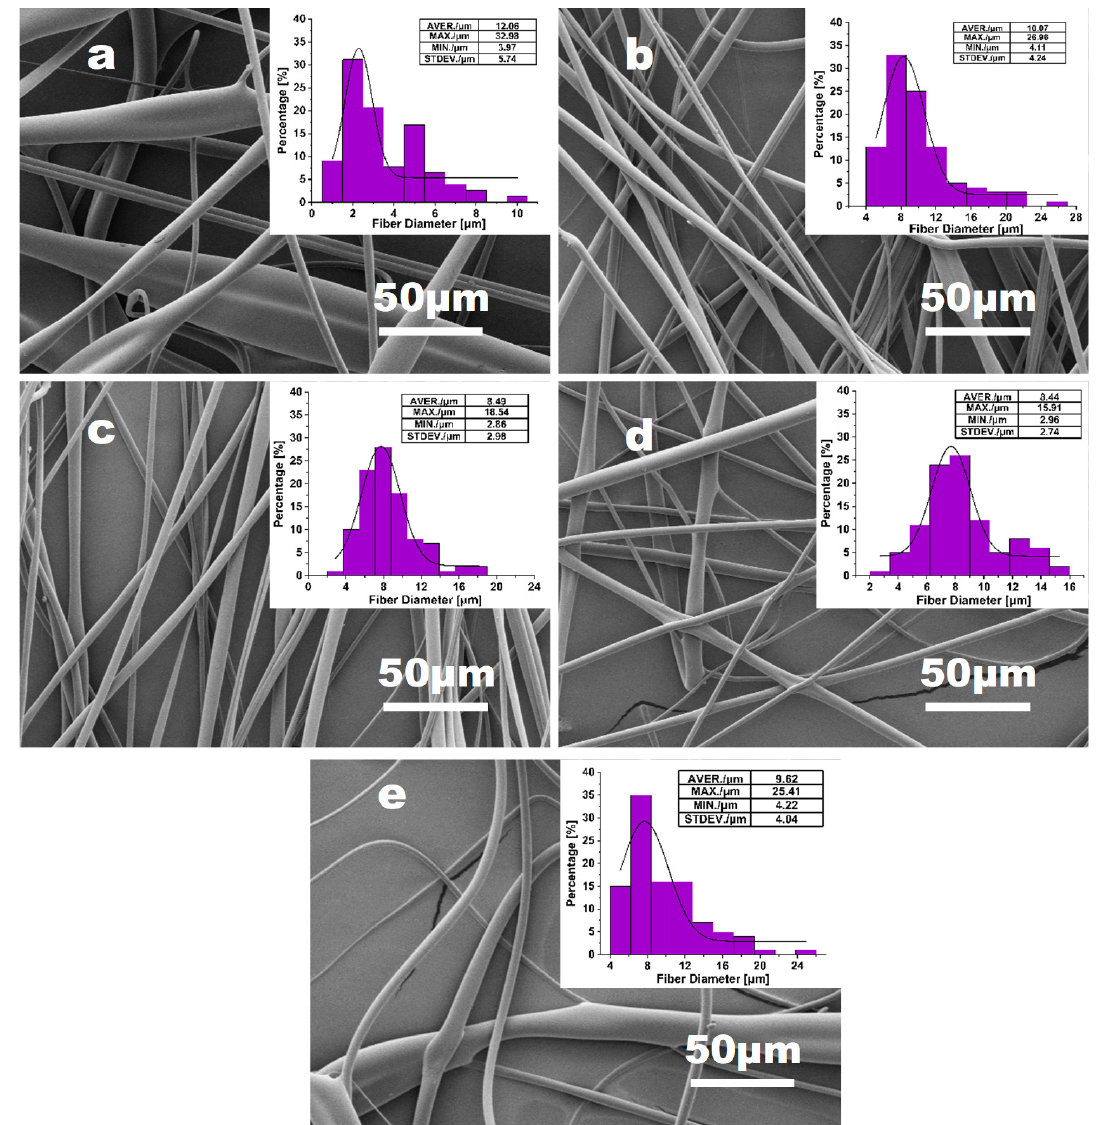
Figure 5. The effect of rotation speed: ( a ) 3500 rpm; ( b ) 4500 rpm; ( c ) 5500 rpm; ( d ) 6500 rpm; ( e ) 7500 rpm on 15% PVA fiber morphology and fiber diameter distribution, with fixed parameters of feeding rate = 3000 mL h − 1 and needle 22# (0.51 mm diameter).